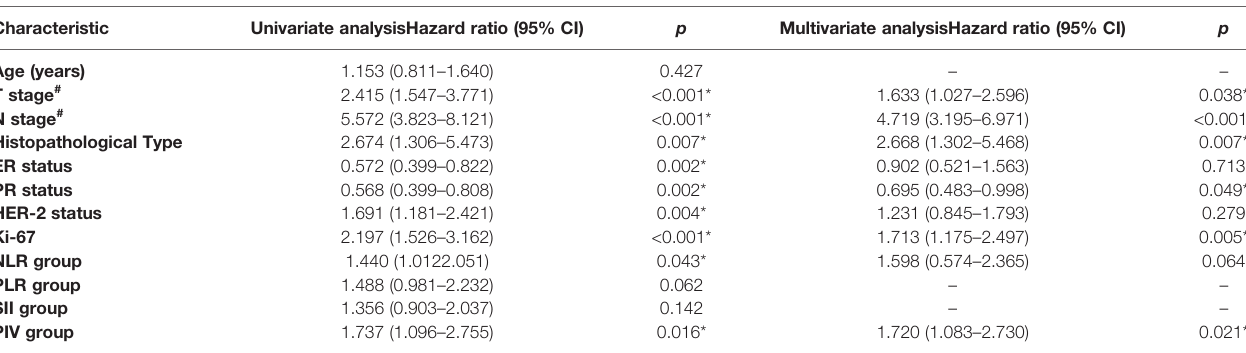
TABLE 3 | Univariate and multivariate analyses of overall